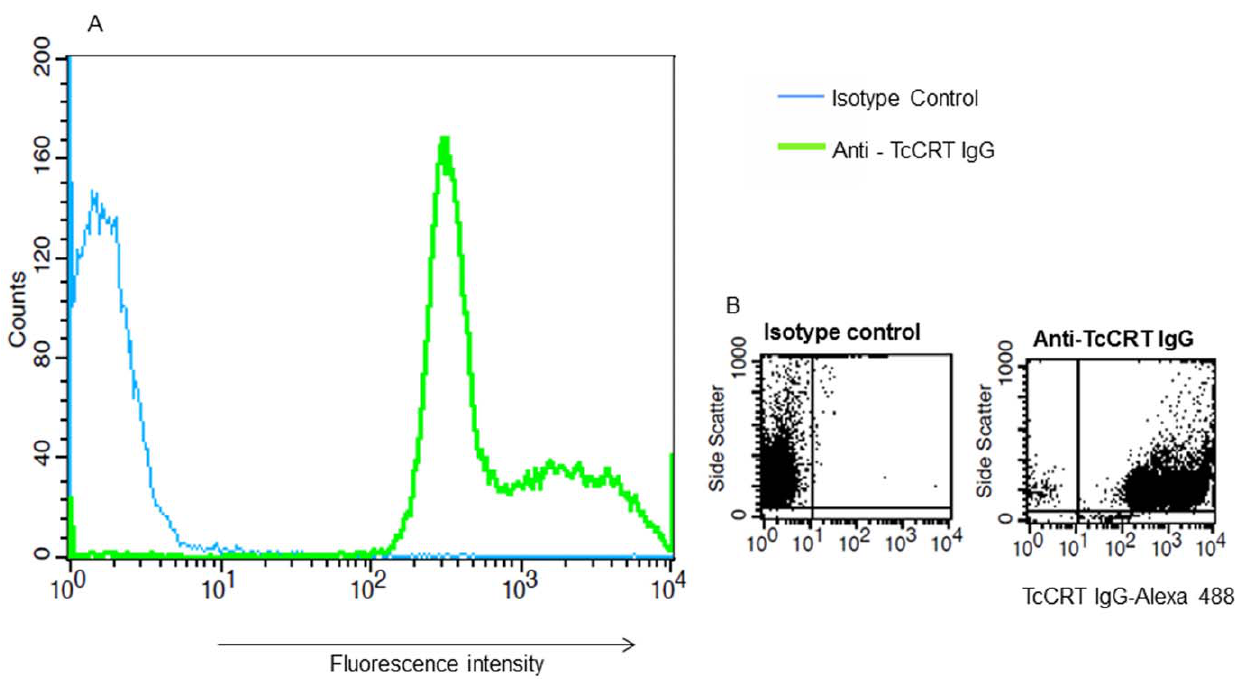
Figure 3. TcCRT is expressed on the surface of T.cruzi trypomastigotes. A , Alexa labeled TcCRT IgG binds to the surface of T. cruzi trypomastigotes as revealed by flow cytometry. Shift in the peak of fluorescence indicates that parasite surface is stained with labeled TcCRT IgG. B , Fluorescence intensity of parasites stained with labeled isotype control (left panel) and anti-TcCRT IgG (right panel) showing the high percentage (99.2%) of stained parasites. This figure shows the results of a representative experiment selected from three independent experiments with similar results.